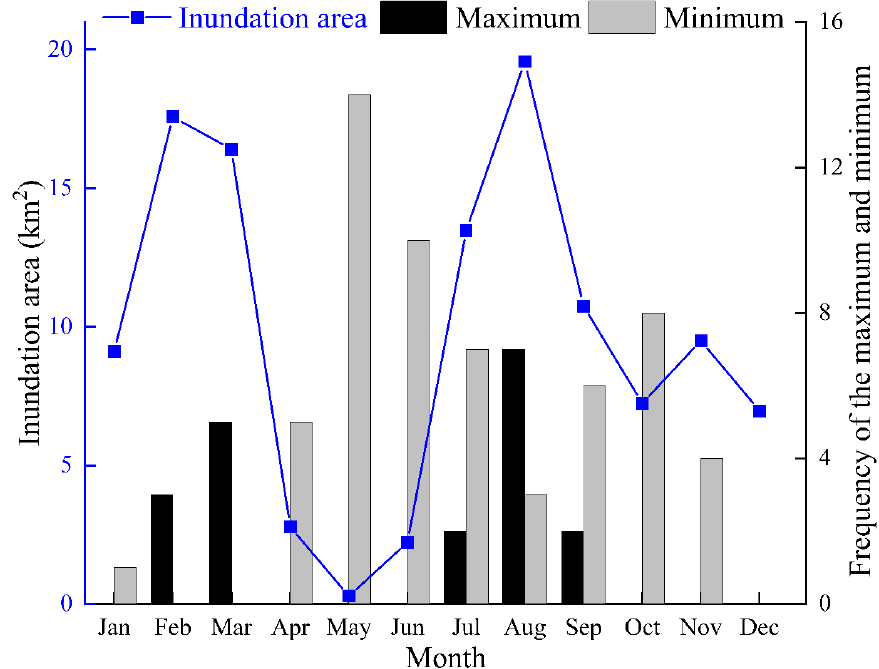
Figure 6. Intra-annual (seasonal) changes in inundation area between 2000 to 2018 within the Daliyaboyi Oasis located along the downstream reaches of the Keriya River and the frequency with which the minimum and maximum values of inundation were observed; data stratified by month.